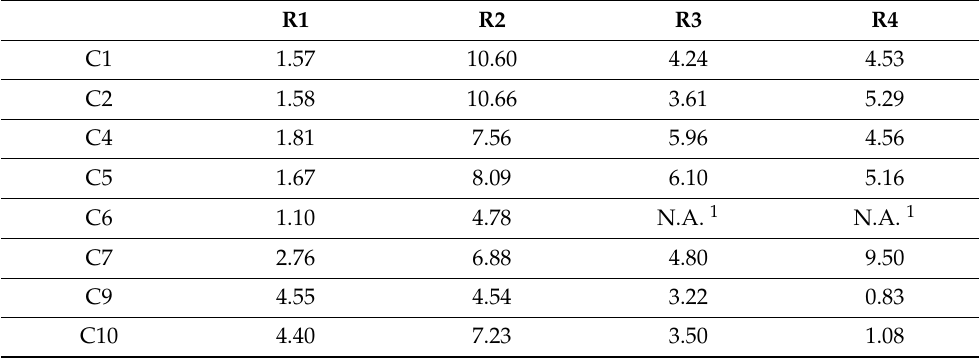
Table 2. PQV for configurations presented in Figure 7 (170 mm pipe).